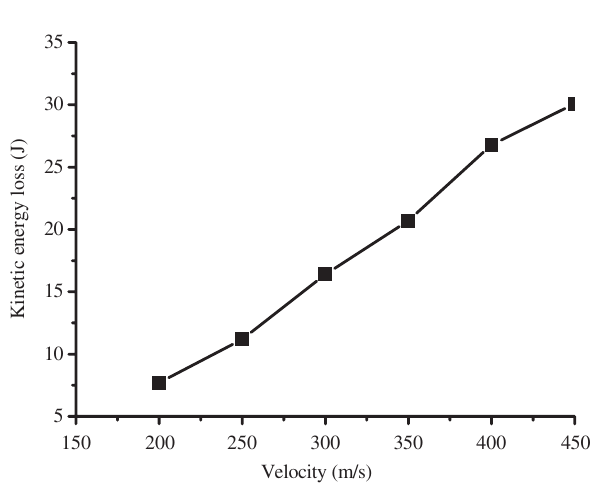
Figure 3: Bullet velocity-kinetic energy reduction